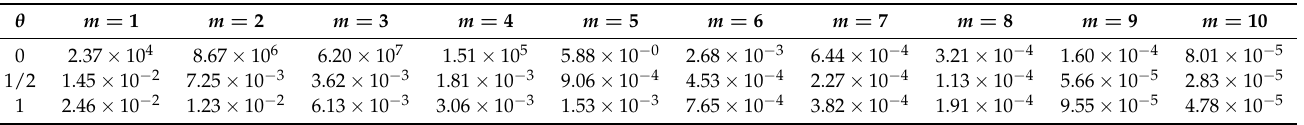
Table 5. L 2 –error comparison among explicit, implicit, and Crank–Nicolson methods with time step size δ t = 0.1/2 m − 1 for Example 2.